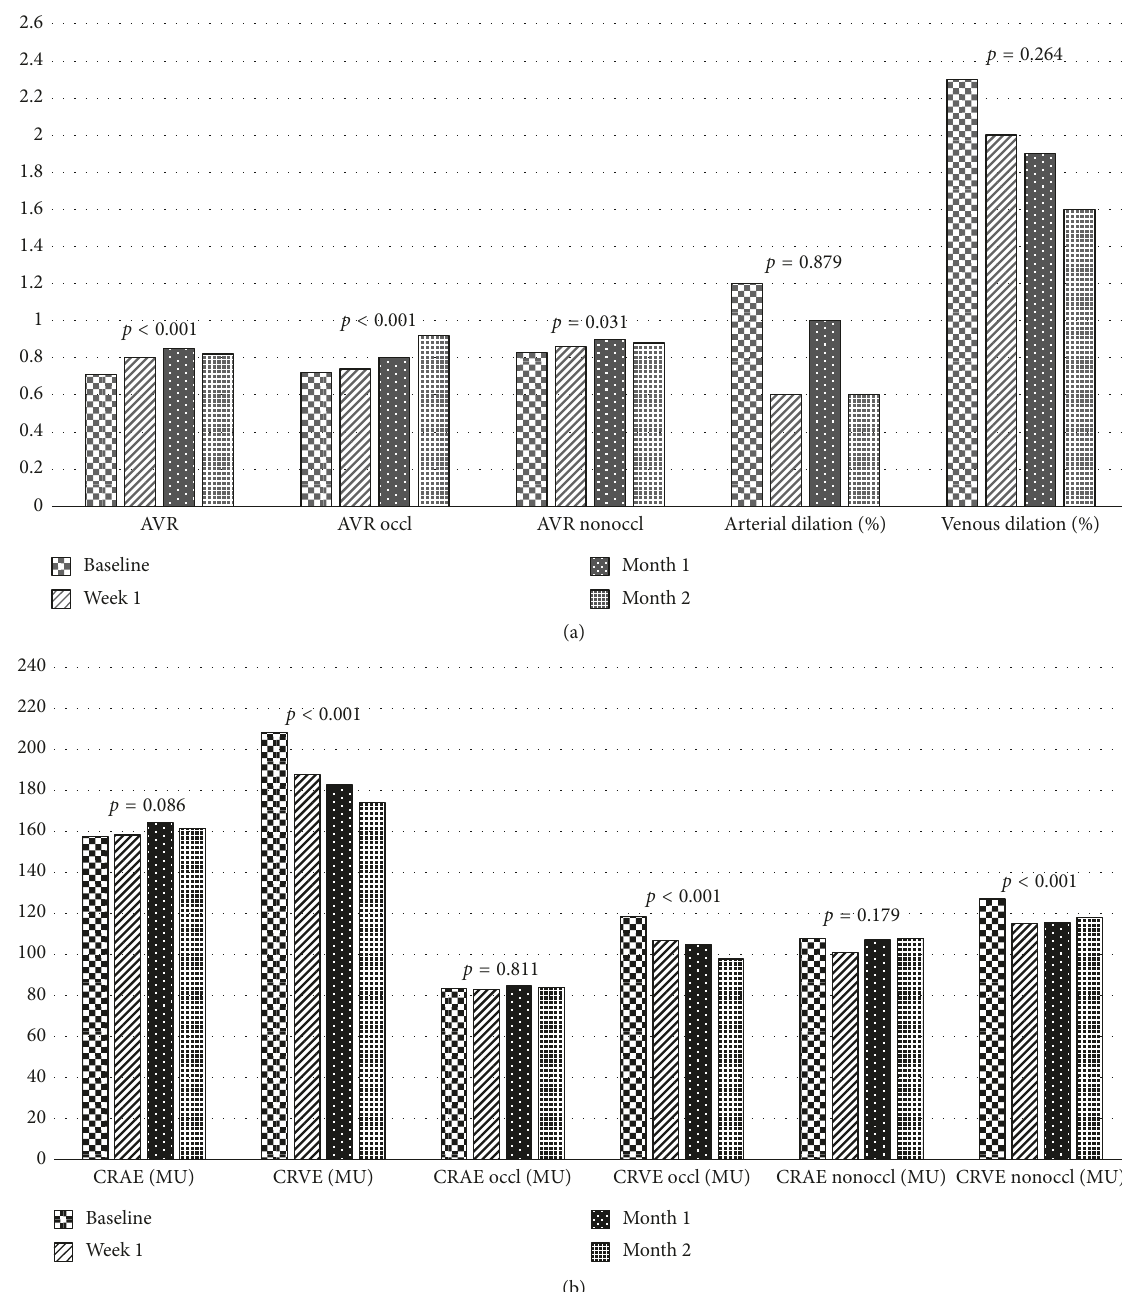
Figure 4: Comparisons of different static (a, b) and dynamic analysis (a) parameters in patients with macular edema secondary to retinal vein occlusion at baseline (before injection) and 1 week, 1month, and 2months after injection with control subjects. AVR � arteriovenous ratio; CRAE � central retinal artery equivalent; CRVE � central retinal vein equivalent; AVR nonoccl � arteriovenous ratio in nonoccluded quadrants of RVO and corresponding quadrants of controls; AVR occl � arteriovenous ratio in occluded quadrants of RVO and cor- responding quadrants of controls; CRVE nonoccl � central retinal vein equivalent in nonoccluded quadrants of RVO and corresponding quadrants of controls; CRVE occl � central retinal vein equivalent in occluded quadrants of RVO and corresponding quadrants of controls; MU � measurement units; values are expressed as mean ± standard deviation and median (25–75